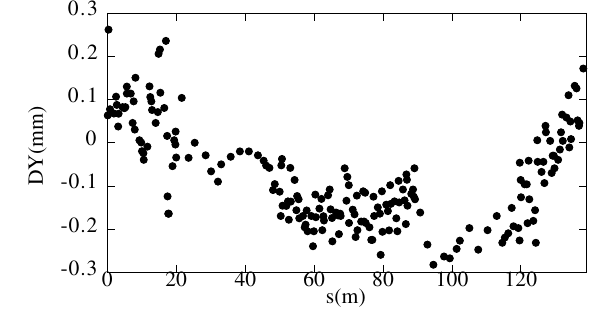
FIG. 2. Measured vertical misalignment.